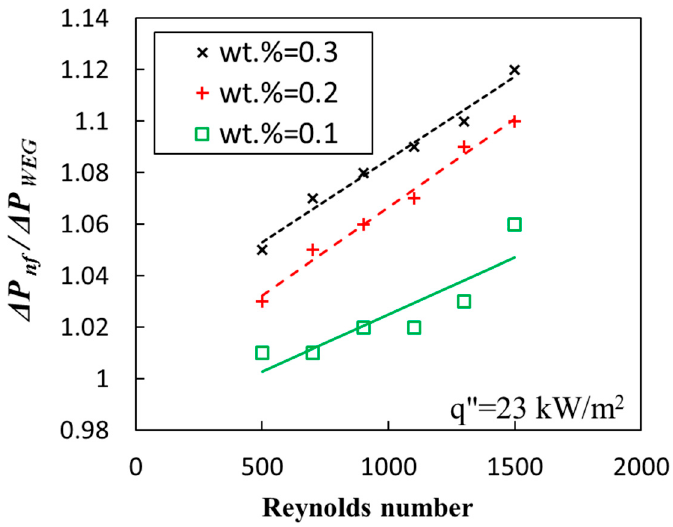
Figure 6. Dependence of the pressure drop (PD) value of the system on the fluid flow rate for WEG and nanofluids at various mass fractions.